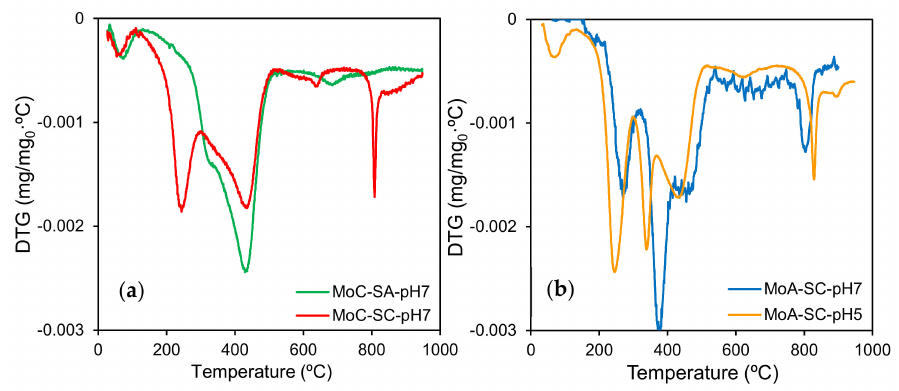
Figure 2. DTG-profiles obtained for the carbonization of organic xerogels: Influence of the ( a ) surfactant nature and ( b ) the pH